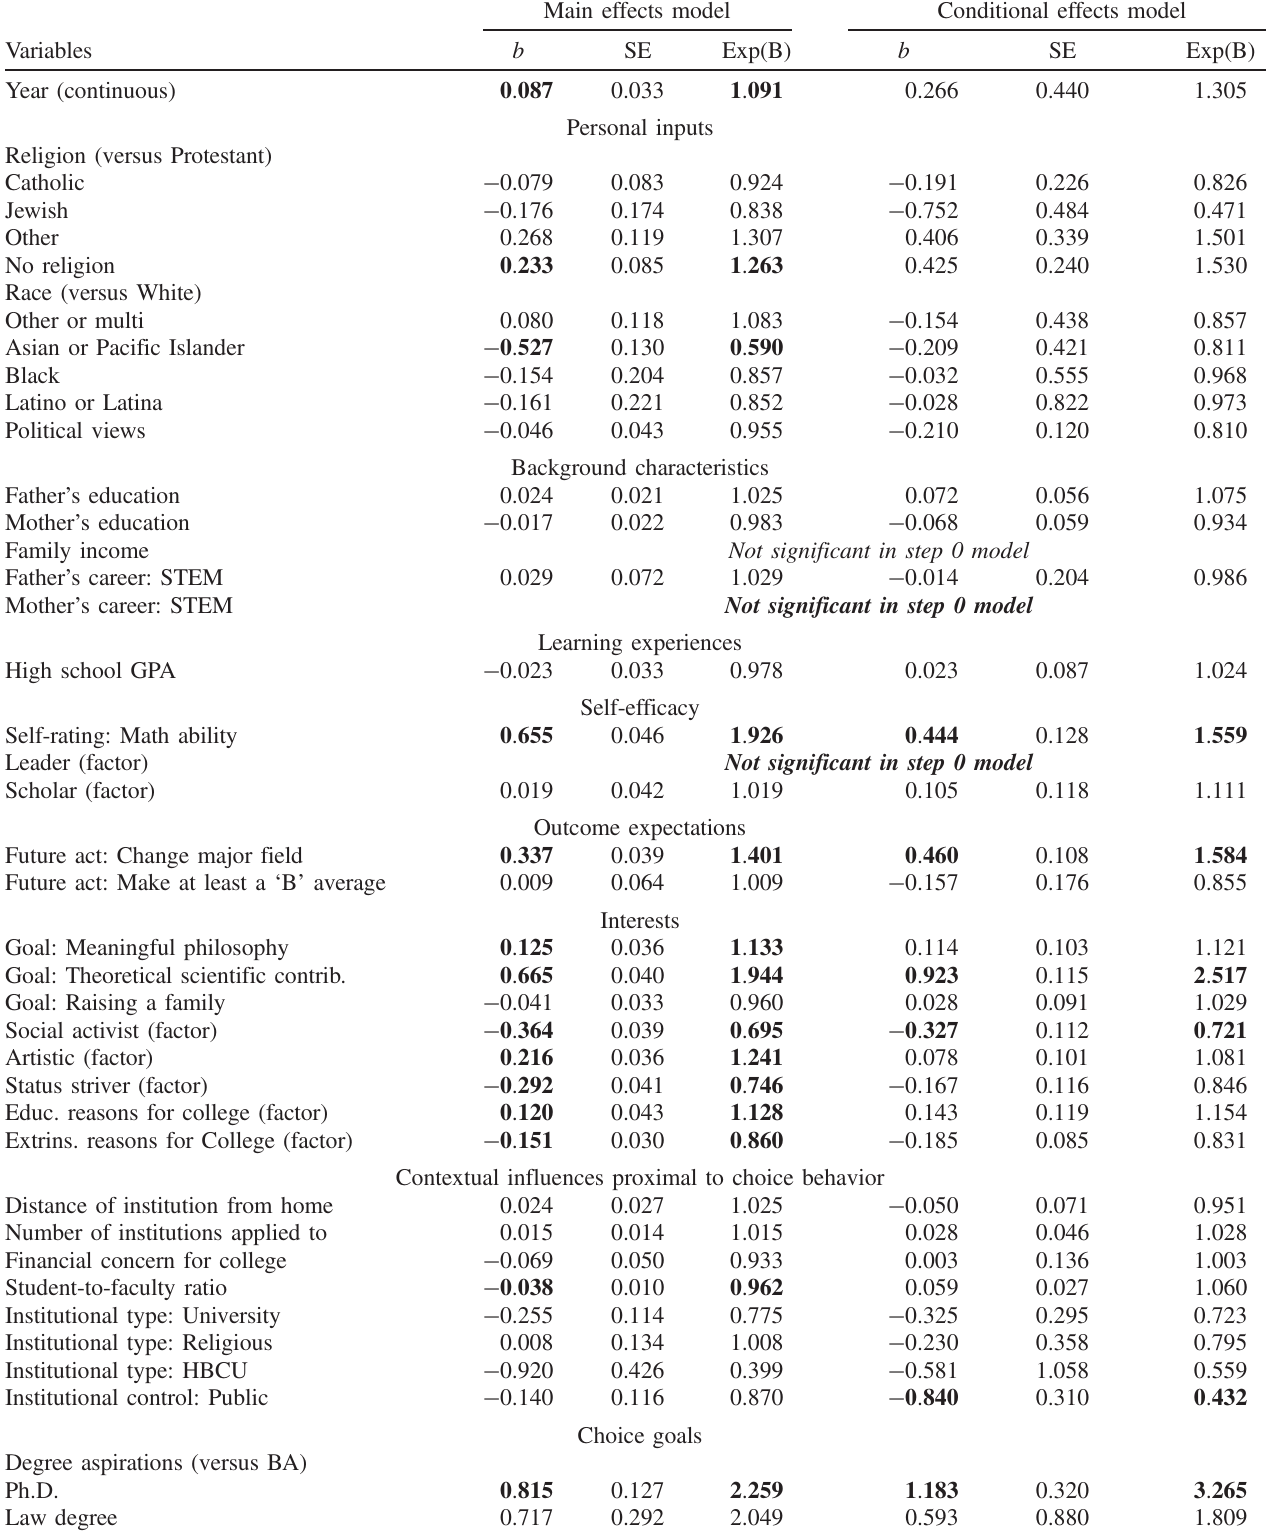
TABLE IV. Logistic regression predicting choice of physics major among women (compared to other STEM majors) ( n ¼ 65 993 ). Bold indicates p < 0 . 01